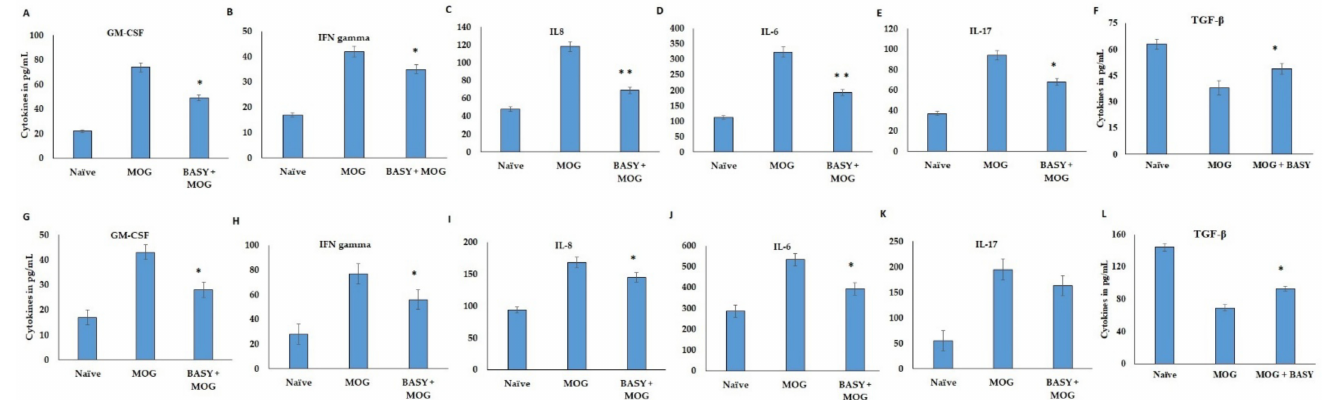
Figure 6. Peripheral and splenic lymphocytes were regulated by BASY administration in MOG- immunized EAE mice. The differential regulation of lymphocytes in MOG-immunized mice was evaluated by progressive inflammatory cytokine markers using an ELISA kit. CD4 and CD65L lymphocytes were isolated from peripheral lymph nodes of MOG-immunized mice and naïve mice. The isolated cells were restimulated with MOG of 1 µ g/mL concentration for 18 h and cells were harvested for cytokine quantification. ( A – F ) GM-CSF, IFN γ , IL-8, IL-6, IL-17 and TGF- β were quantified in MOG-stimulated peripheral spinal lymph nodes CD4 cells. The isolated cells were re-stimulated with MOG of 1 µ g/mL concentration for 12 h and cells were harvested for cytokine quantification. ( G – L ) GM-CSF, IFN γ , IL-8, IL-6, IL-17 and TGF- β were quantified in MOG-stimulated splenic CD4 cells. CD4 and CD65L lymphocytes were isolated from splenic lymphoid cells (SLC) of MOG -immunized mice and naïve mice. Data were pooled from three independent experiments and shown as mean ± SD. * p < 0.05. ** p < 0.01. GM -CSF—granulocyte-macrophage